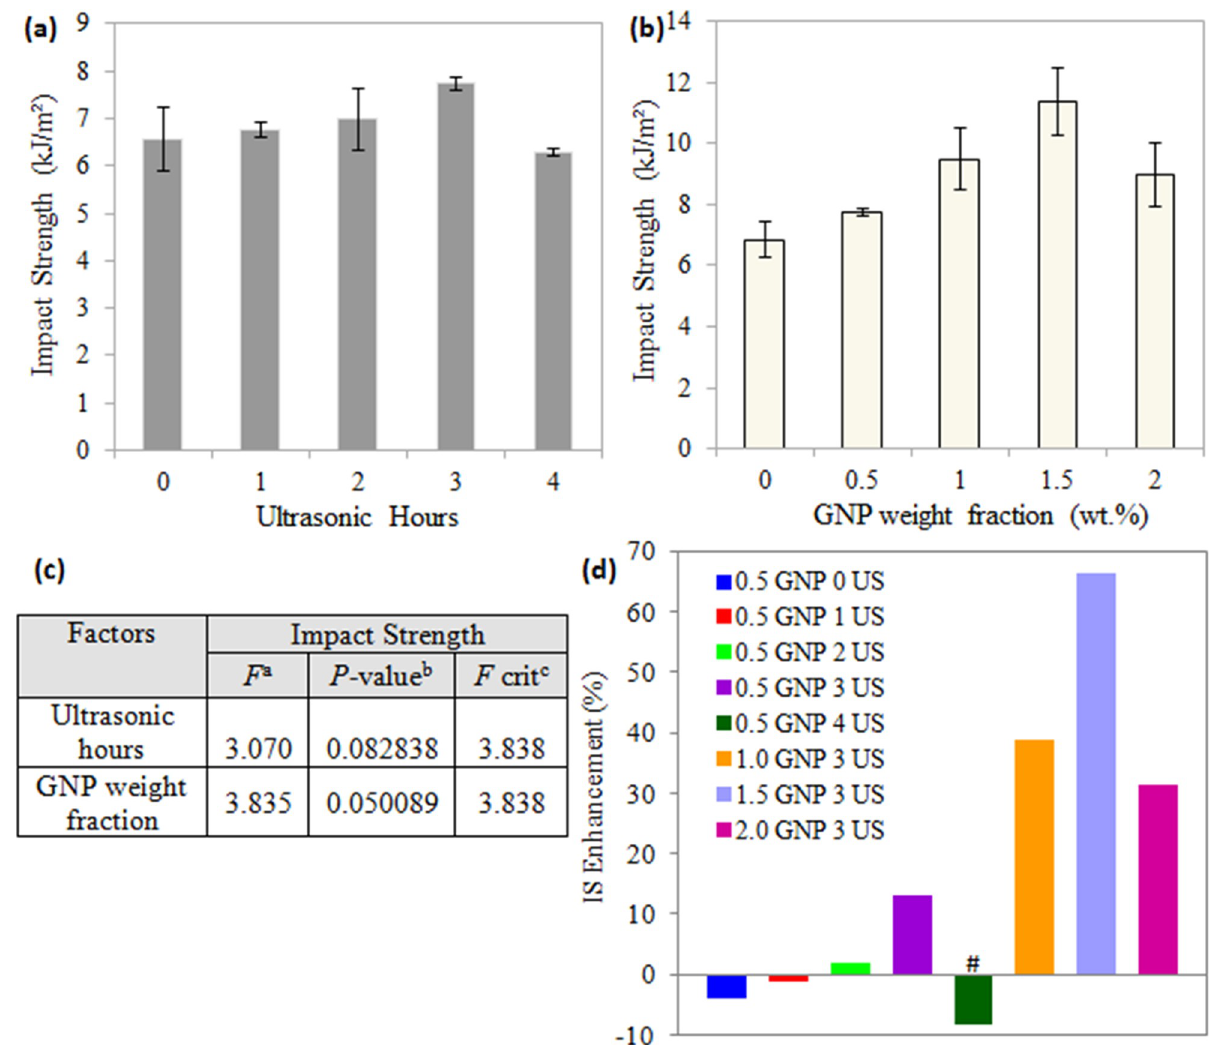
Fig 3. Impact strength (IS) of TPNR/GNP composites (a) treated with different ultrasonic (US) hours, (b) at various filler weight fractions, (c) ANOVA analysis for both factors in impact properties, and (d) IS enhancement compared with pure TPNR. Note: a F value = mean between groups variance/ mean within group variance; b Probability from 0 to 1; c critical F value based on F distribution. Groups with a significant difference (p < 0.05) compared to TPNR/GNP composite assisted with 3 hours US is indicated by #